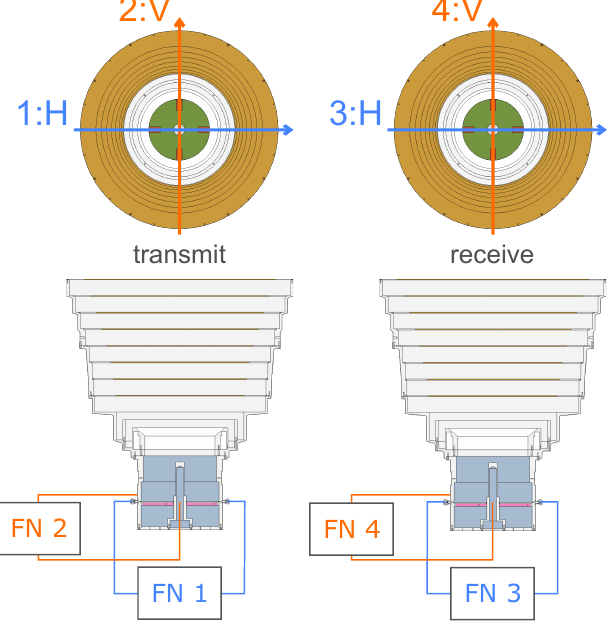
Figure 5. Representation of the antenna coupling setup. Shown on the bottom is a cut through both antennas with their feed-network (FN) setup. The top down view into the antennas shows the resulting polarization when exciting the antenna using the respective feed-network. The antenna on the left is referred to as the transmitting antenna, while the right antenna is consequently set as the receiving